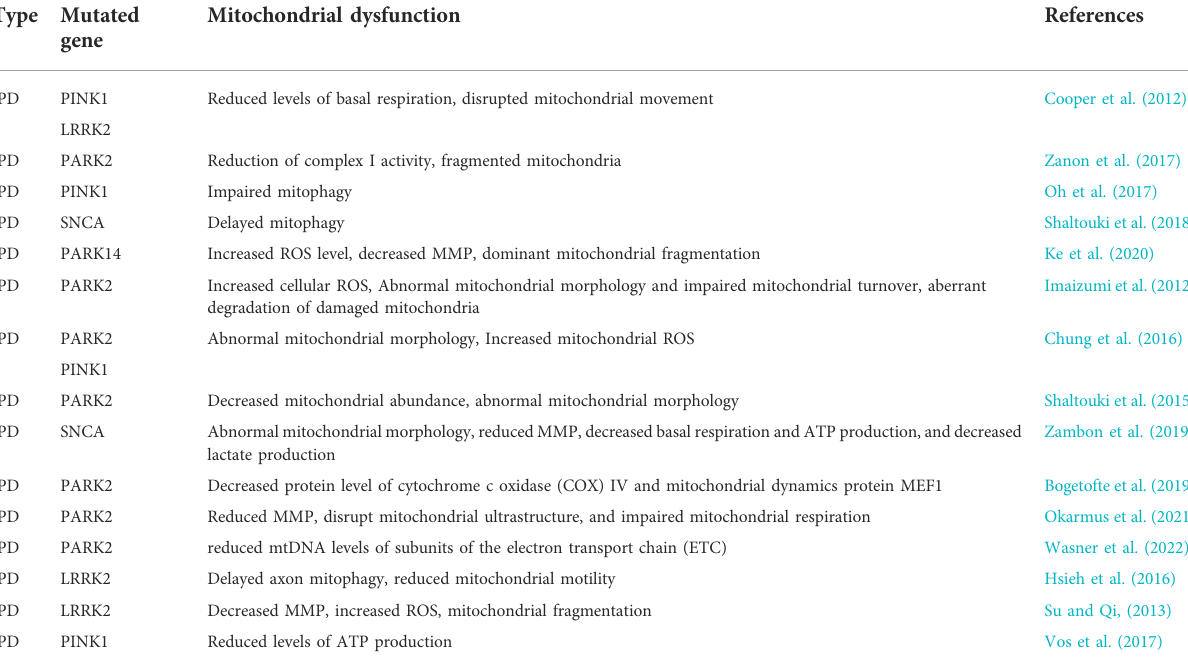
TABLE 3 Mitochondrial dysfunction in iPSC-derived DA neuron modeling of